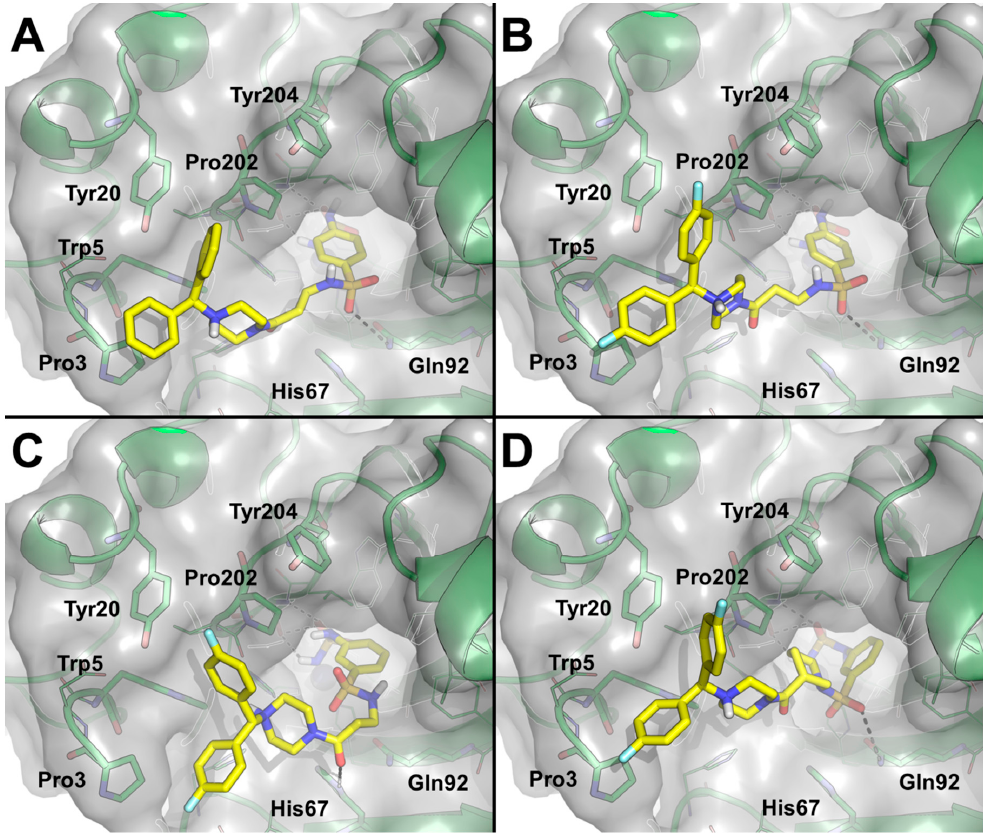
Figure 2. Predicted binding mode of compounds 6c ( A ), 6f ( B ), 6e ( C ) and 6k ( D ). Small molecules are showed as yellow sticks, non-polar hydrogen atoms are omitted. The crystallographic structure of hCA I (PDB ID: 4WR7) is shown as green cartoon and grey transparent surface. Residues within 5 Å from the ligands are showed as green lines, residues contacted by the inhibitors and described in the text are showed as sticks and labeled. The catalytic Zn(II) ion is shown as grey sphere. Polar interactions between inhibitors and hCA I are highlighted by dashed lines.